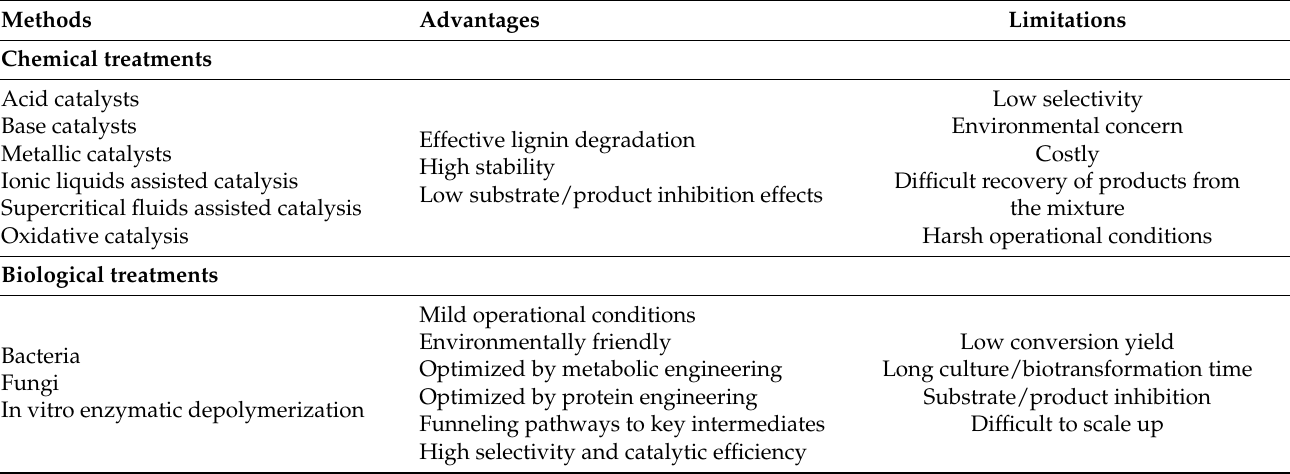
Table 1. A brief overview of chemical and biological lignin depolymerization